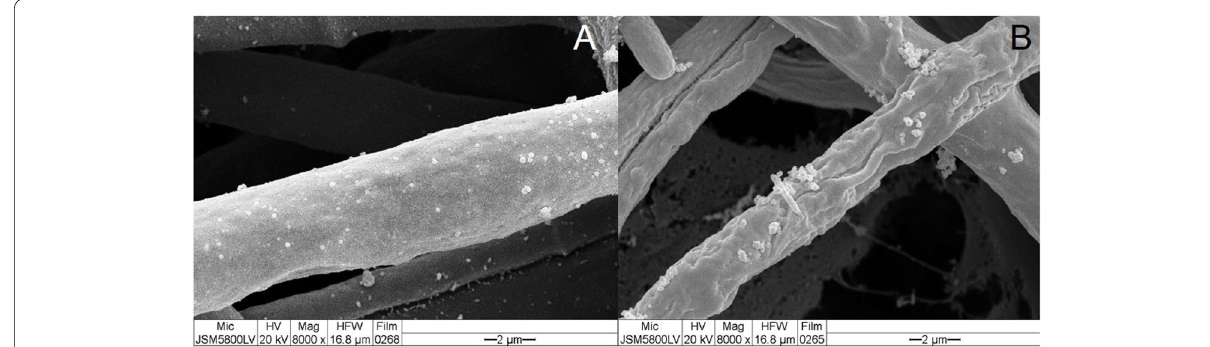
Fig. 5 SEM images of Stagonosporopsis cucurbitacearum hyphae. A Hyphae treated with crude metabolites of muskmelon seedlings B Hyphae treated with crude metabolites of muskmelon seedlings inoculated with Trichoderma asperelloides . Note the abnormal cell walls (arrows).